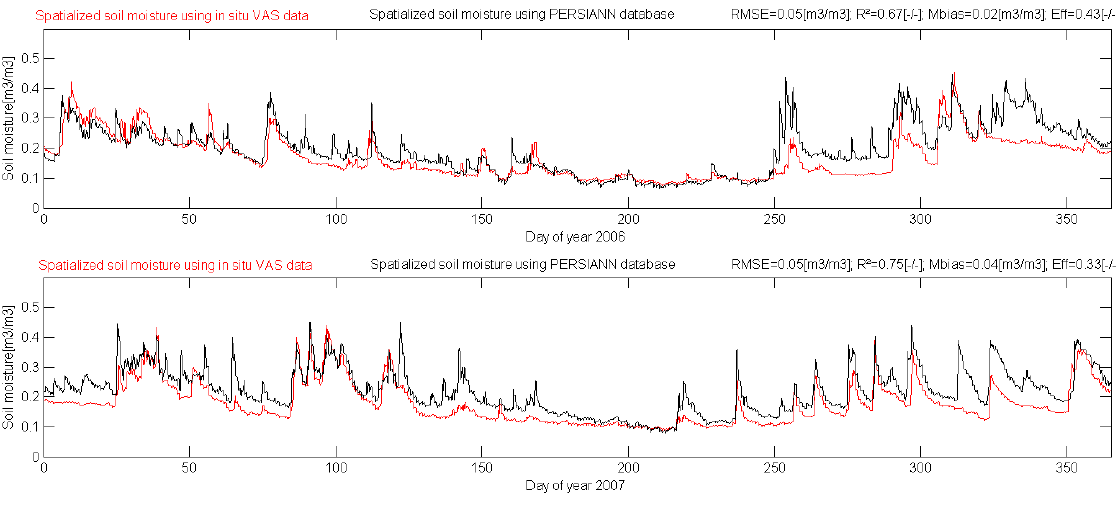
Fig. 8. Comparison between spatialized soil moisture databases obtained using in situ rain gauge observations from VAS area (red line) and the PERSIANN satellite rainfall estimates (black line) for 2006 (upper figure) and 2007 (bottom figure).